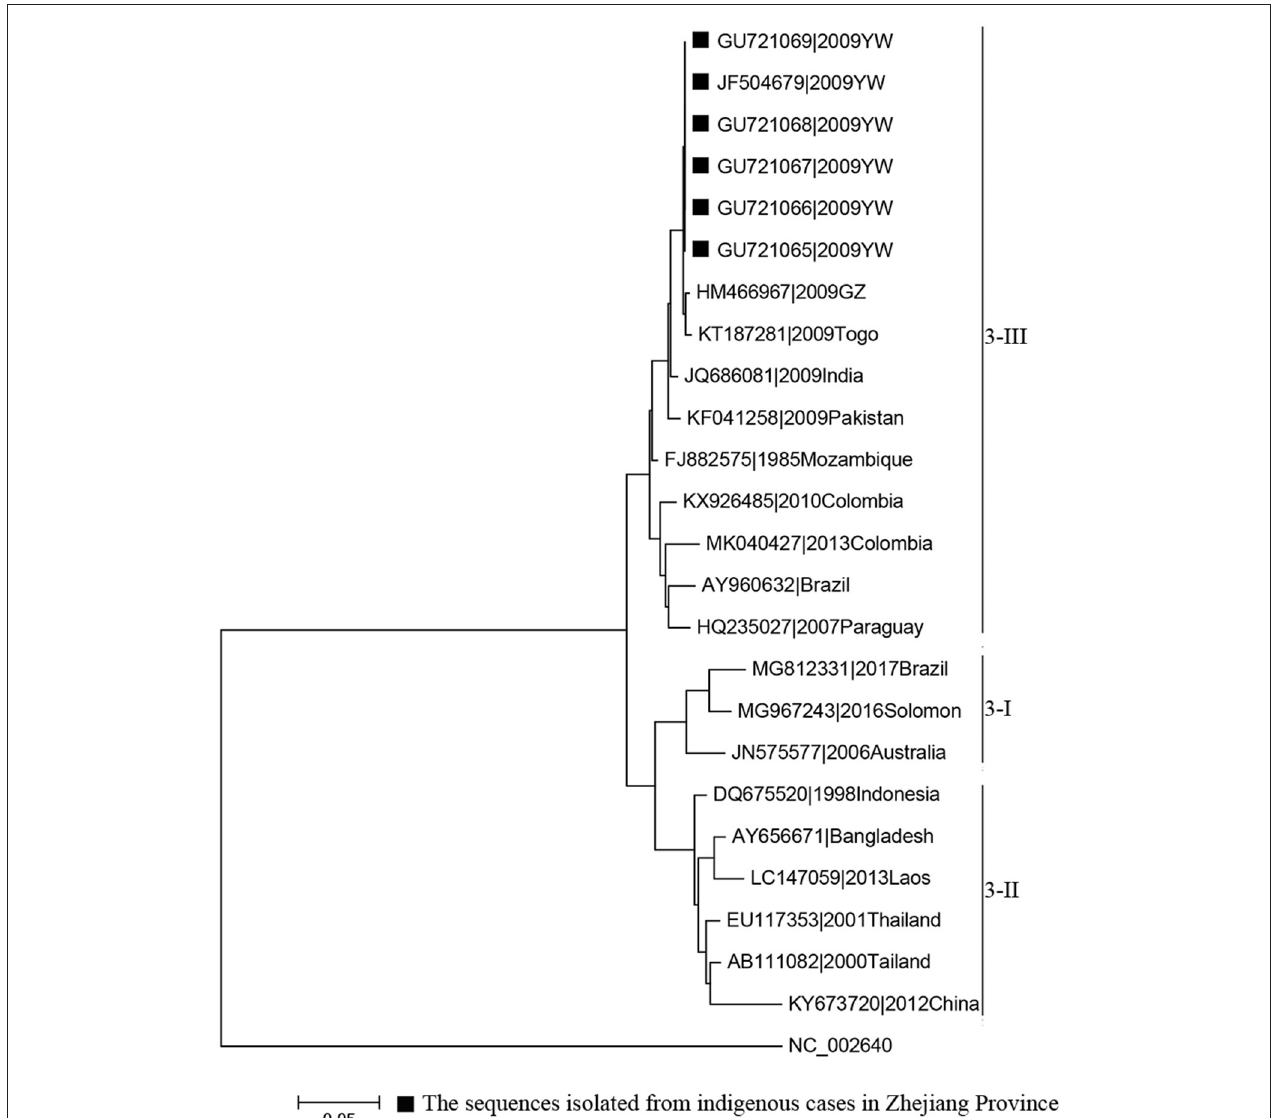
FIGURE 6 | Phylogenetic tree of DENV-3 strains based on the E